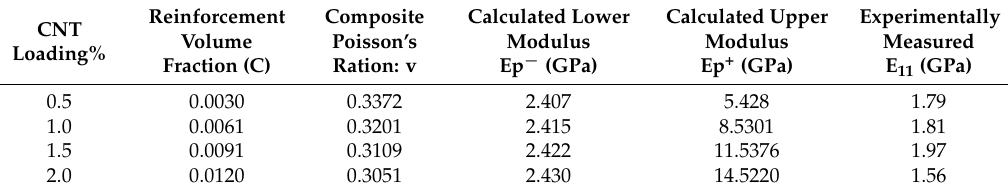
Table 3. Calculated and experimental values of modulus.